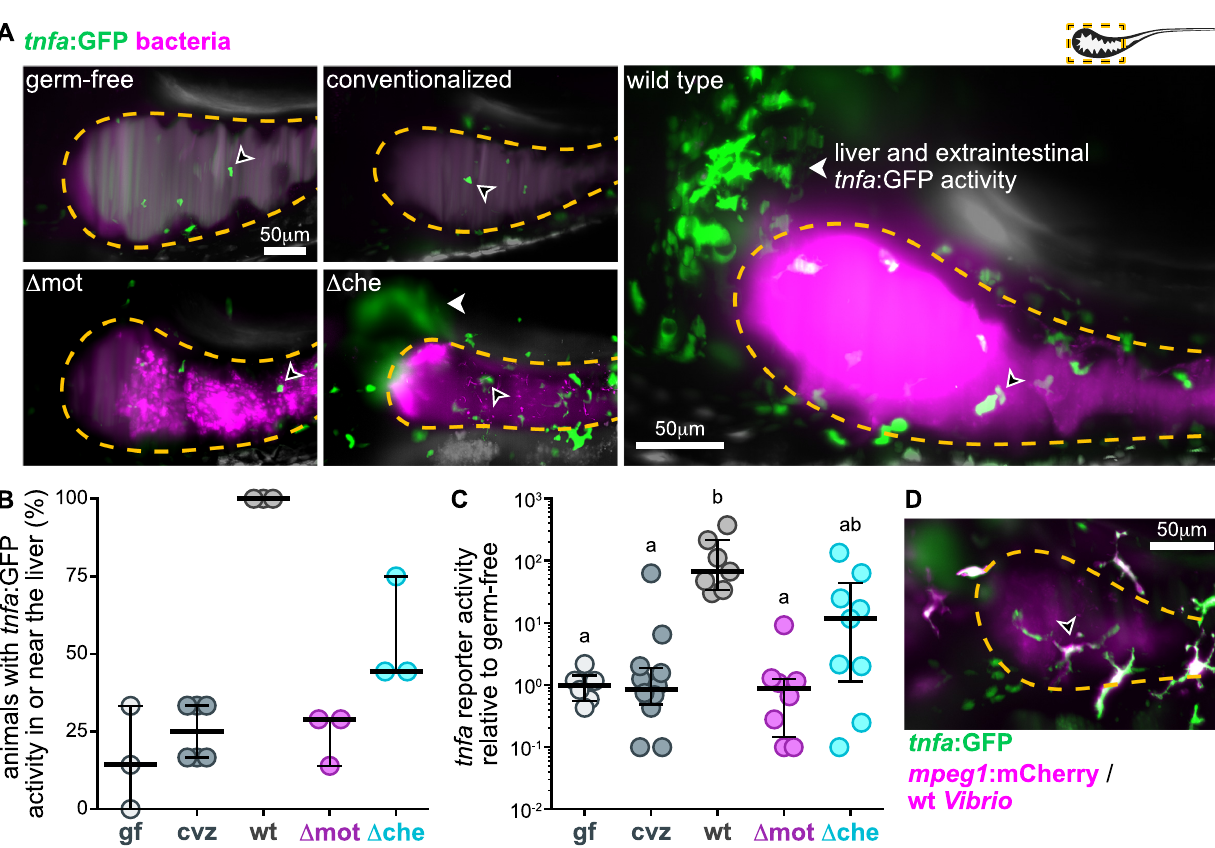
Fig 6. Motile bacterial cells induce local and systemic tnfa expression. (A) Maximum intensity projections acquired by LSFM of the foregut region of tnfa :GFP transgenic zebrafish raised germ-free, with a complex microbial community (conventionalized), or colonized solely with dTomato-expressing (magenta) wild-type Vibrio , Δ mot, or Δ che. Animals were imaged at 24 hpi. Dashed lines mark the approximate intestinal boundaries. Empty arrowheads mark host cells with tnfa :GFP reporter activity. Solid arrowheads mark tnfa :GFP reporter activity in extraintestinal tissues in or near the liver. (B) Percent of zebrafish subjected to different colonization regimes with tnfa :GFP activity in or near the liver; > 6 animals/group were blindly scored by 3 researchers. Bars denote medians and interquartile ranges. (C) Total GFP fluorescence intensity across the foregut region normalized to median gf fluorescence intensity. Bars denote medians and interquartile ranges. Letters denote significant differences. p < 0.05, Kruskal-Wallis and Dunn’s multiple comparisons test. (D) Maximum intensity projections acquired by LSFM of the foregut region of a tnfa :GFP, mpeg1 :mCherry (magenta) transgenic zebrafish colonized with dTomato-expressing wild-type Vibrio (magenta). Animal was imaged at 24 hpi. Open arrowhead indicates a tnfa + / mpeg1 + cell. Underlying data plotted in panels B and C are provided in S1 Data. cvz, conventionalized; gf, germ-free; GFP, green fluorescent protein; hpi, hours post inoculation; LSFM, light sheet fluorescence